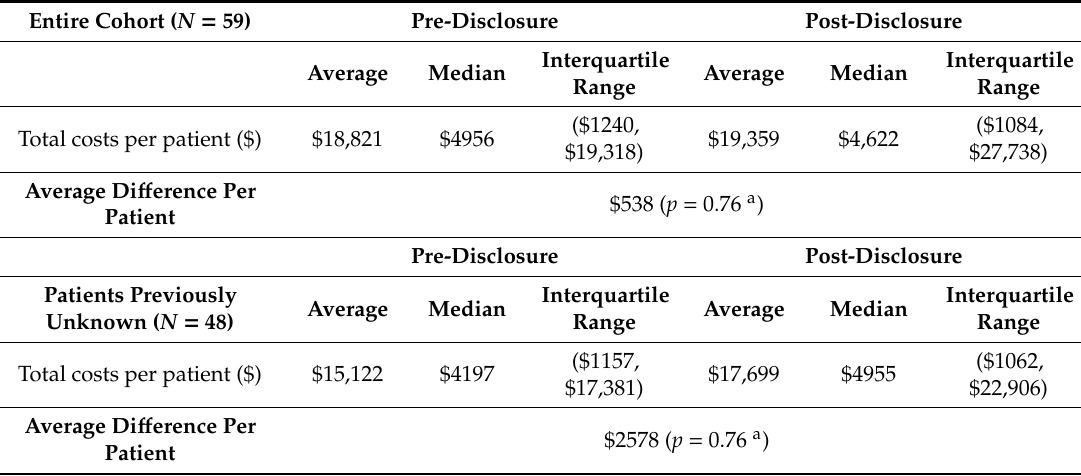
Table 3. Cost in the pre- and post-disclosure of results.